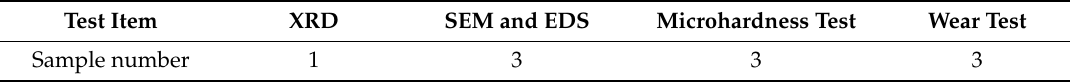
Table 2. Number of samples required for different tests.